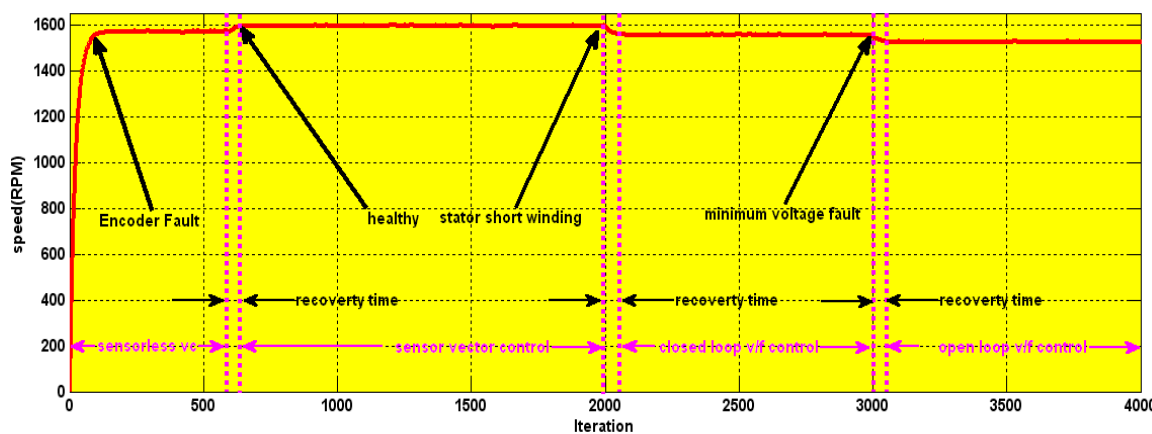
Figure 26. Control system recovery.